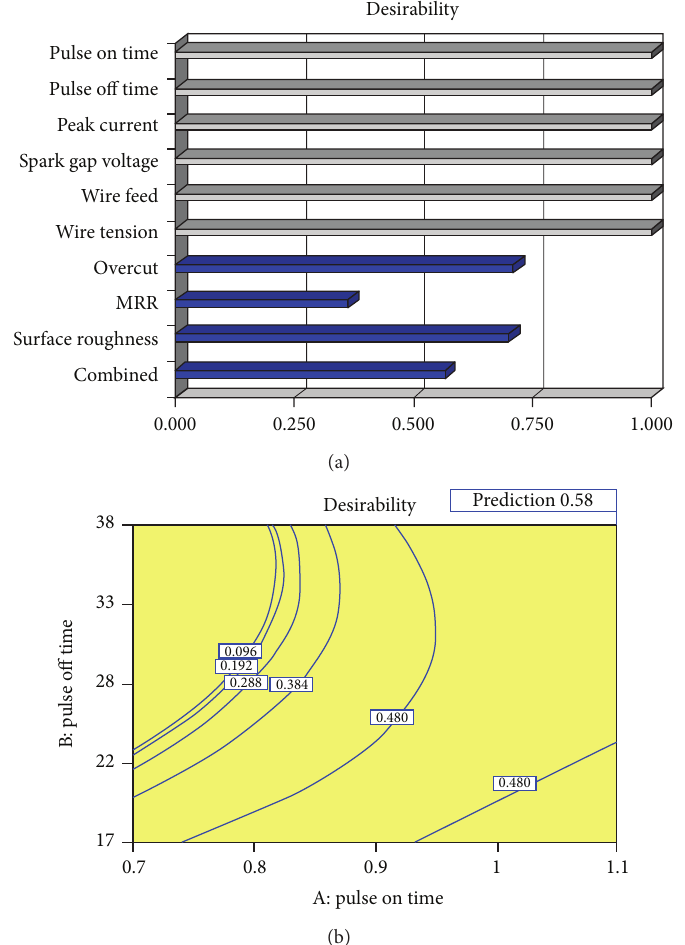
Figure 12: (a) Bar histograms and (b) contour plot for results of overall desirability functions (at 𝑇 on = 1.1 𝜇 s, 𝑇 off = 38 𝜇 s, Ip = 165A, SV = 40V, WF = 4m/min, WT = 1400